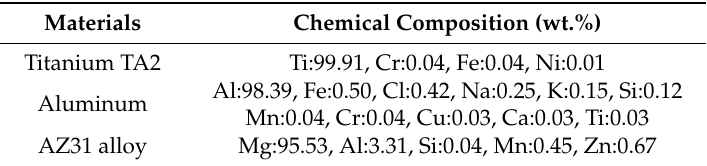
Table 1. Chemical composition of foil raw